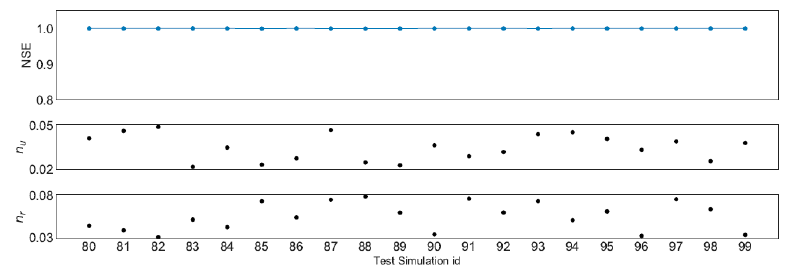
Figure 6. Performance of the surrogate model for the testing data set.